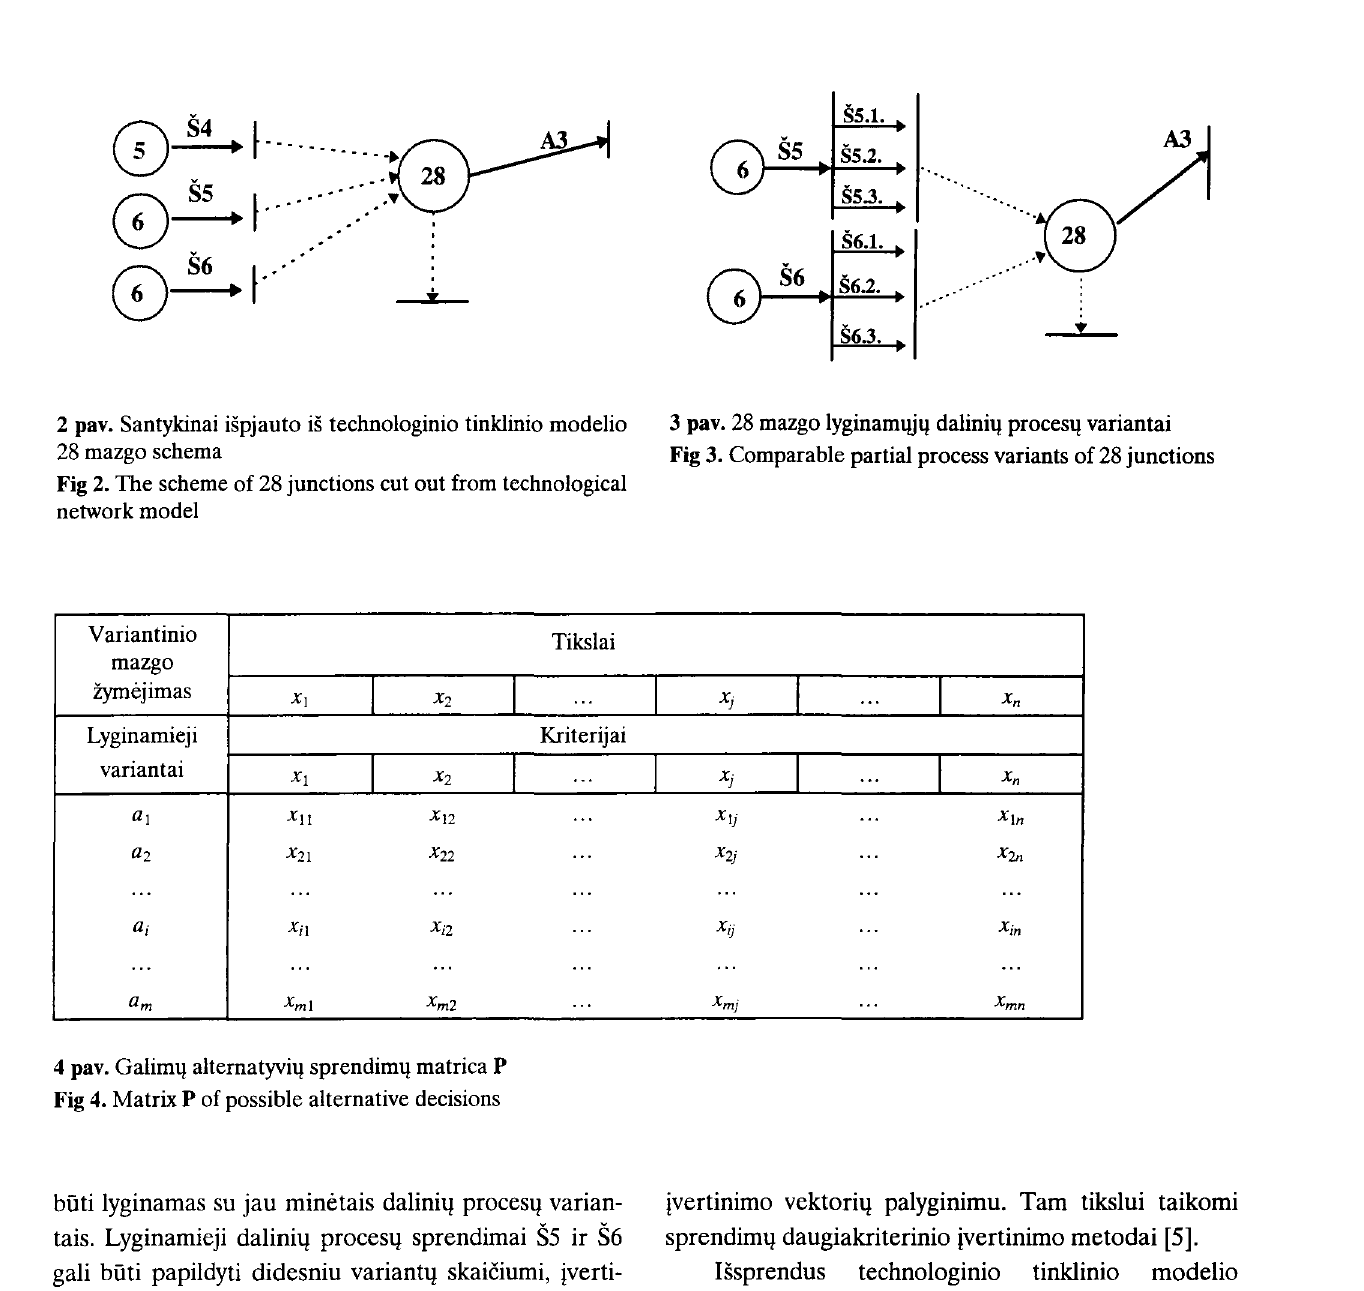
Fig 2. The scheme of 28 junctions cut out from technological network model